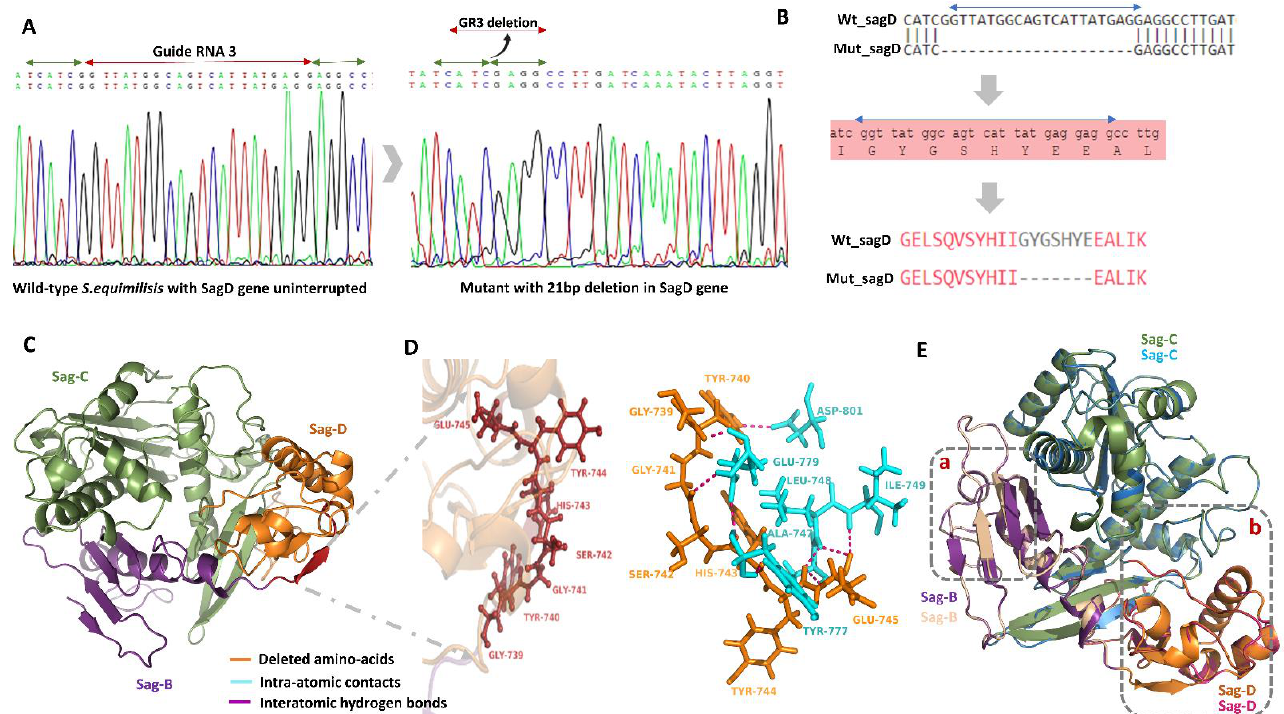
Figure 2. Gene editing of the SagD gene using GR3-PCRISPomyces-2. ( A ) Native SagD gene without any gene editing and mutant SagD genes with 21 deleted nucleotides complementary to GR3. ( B ) Alignment of wild-type and mutant SagD genes (nucleotide sequence) for exploring change in the amino acids sequence. ( C ) SagBCD complex highlighting deleted amino acids with red color. ( D ) The significance of the seven highlighted amino acids in the synthesis and folding of the SagBCD complex. Intra-atomic connections were depicted in magenta using hydrogen bonding within less than 3°A distance (dashed lines). ( E ) Structural superimposition of wild-type and mutant SagBCD complexes. SagB, SagC, and SagD are shown in purple, green, and orange color in wild-type while for mutant, cream, blue, and pink were shown, respectively. The major structural difference is highlighted in boxes a and b. Areas with comparable folds will have merged colors, whilst areas with different folds will not have merged regions.